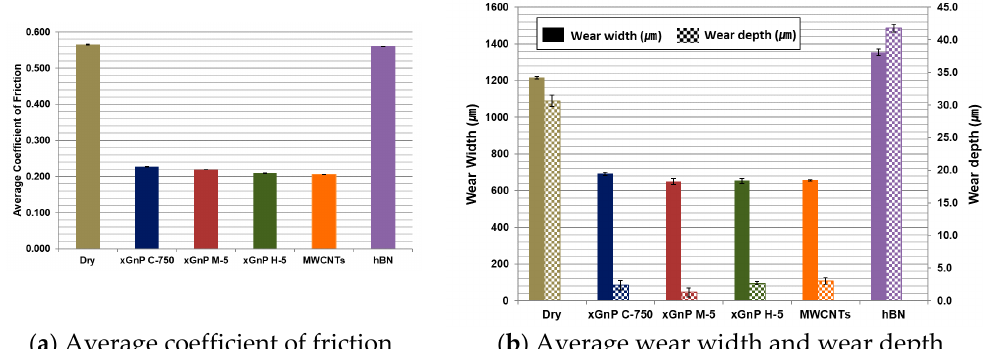
Figure 4. Average coefficient of friction and wear values in each case.